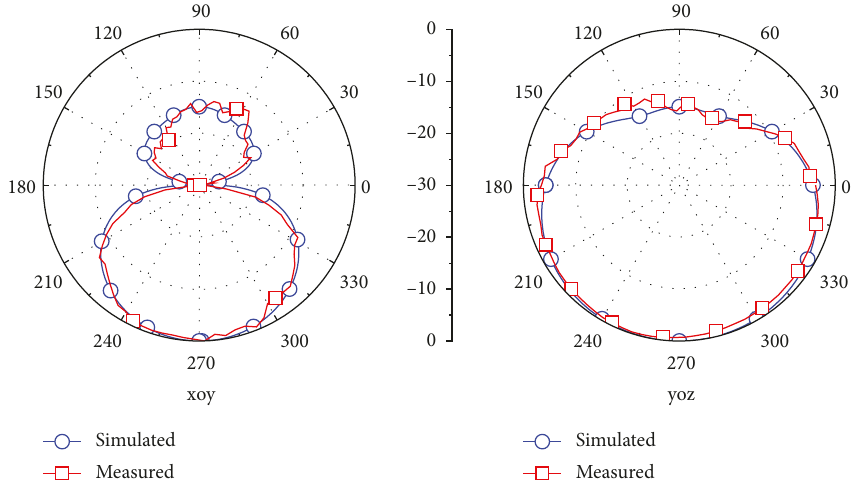
Figure 12: Simulated and measured radiation patterns at 2.4GHz.